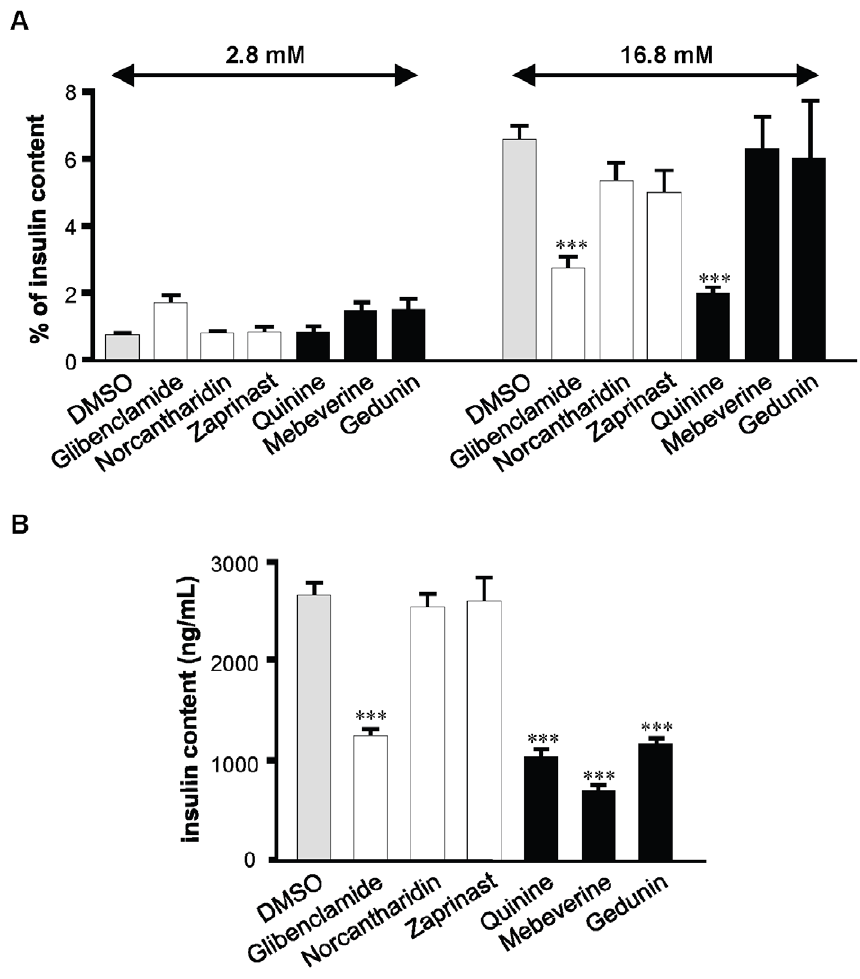
Figure 6. Drugs altering the synchrony index modulate the function of MIN6 cells. ( A ) Insulin release was tested during a 30 min exposure to either 2.8 mM ( left panel ) or 16.8 mM glucose ( right panel ) in cells that had been exposed for 24 h to 10 m M the drugs selected in the secondary screening. No drug significantly altered the basal insulin release ( left panel ). All drugs, but glibenclamide and quinine, also increased to control levels their fractional insulin release ( expressed as percentage of insulin content ), when challenged with a high glucose level ( right panel ). ( B ) The insulin content of MIN6 cells was reduced by all drugs decreasing the synchrony index and by glibenclamide. Data are means + SE of three independent experiments. ***P , 0.001 versus DMSO-exposed controls.